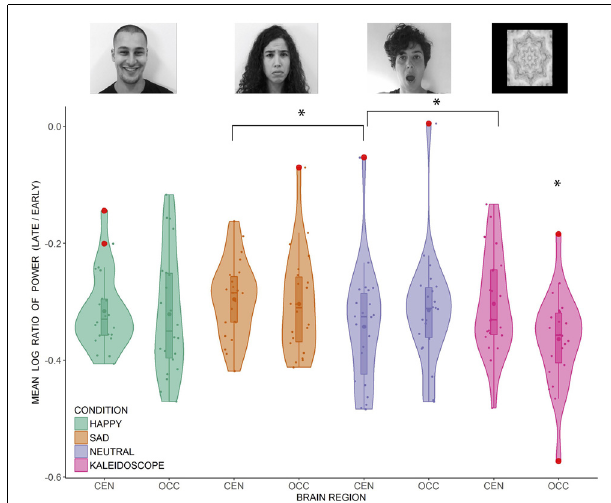
FIGURE 2 | Distribution of the individual mean log ratio scores of 22 participants (dots) in the happy, sad, neutral face and non-biological stimulus conditions at the central and occipital regions. Outliers ( > 1.5 × interquartile range) are represented by the red disks. Inside the boxplots, dots represent the means and horizontal lines represent the medians. The density plots around the data points represent the kernel probability density of the data at different values. CEN, central region; OCC, occipital region. Significant differences are marked by an asterisk [ p < 0.05, false discovery rate (FDR)